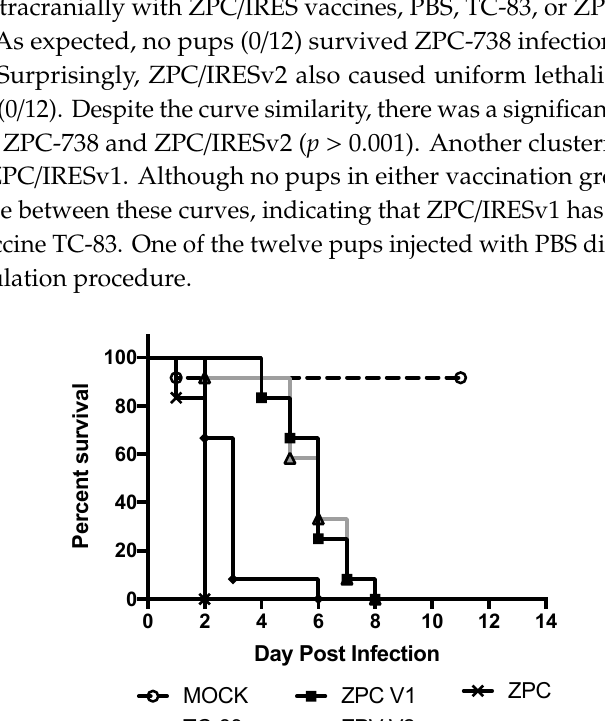
Figure 5. Survival following intracranial injection in neonatal murine pups.